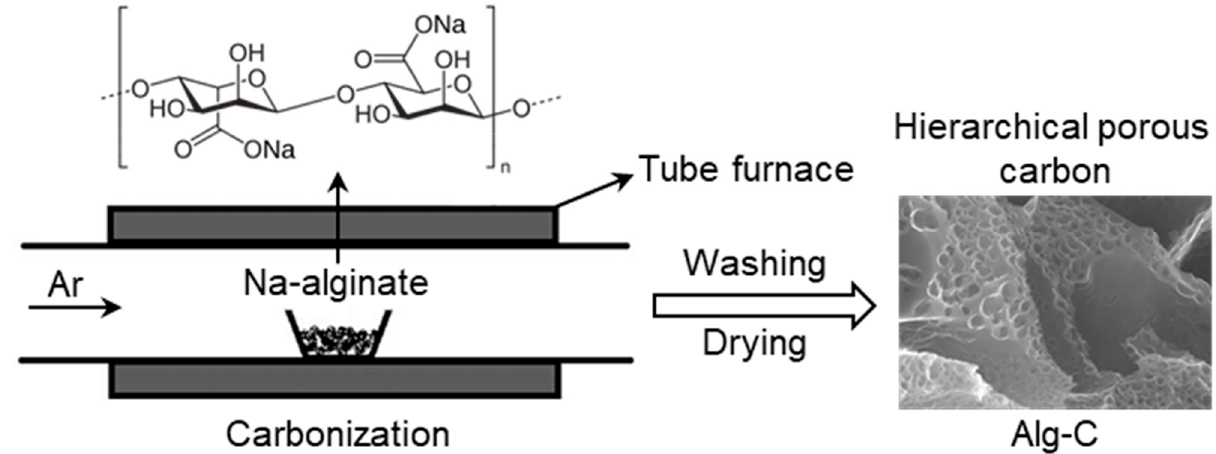
Figure 1. Schematic illustration of the preparation process of carbonaceous Alg ‐ C